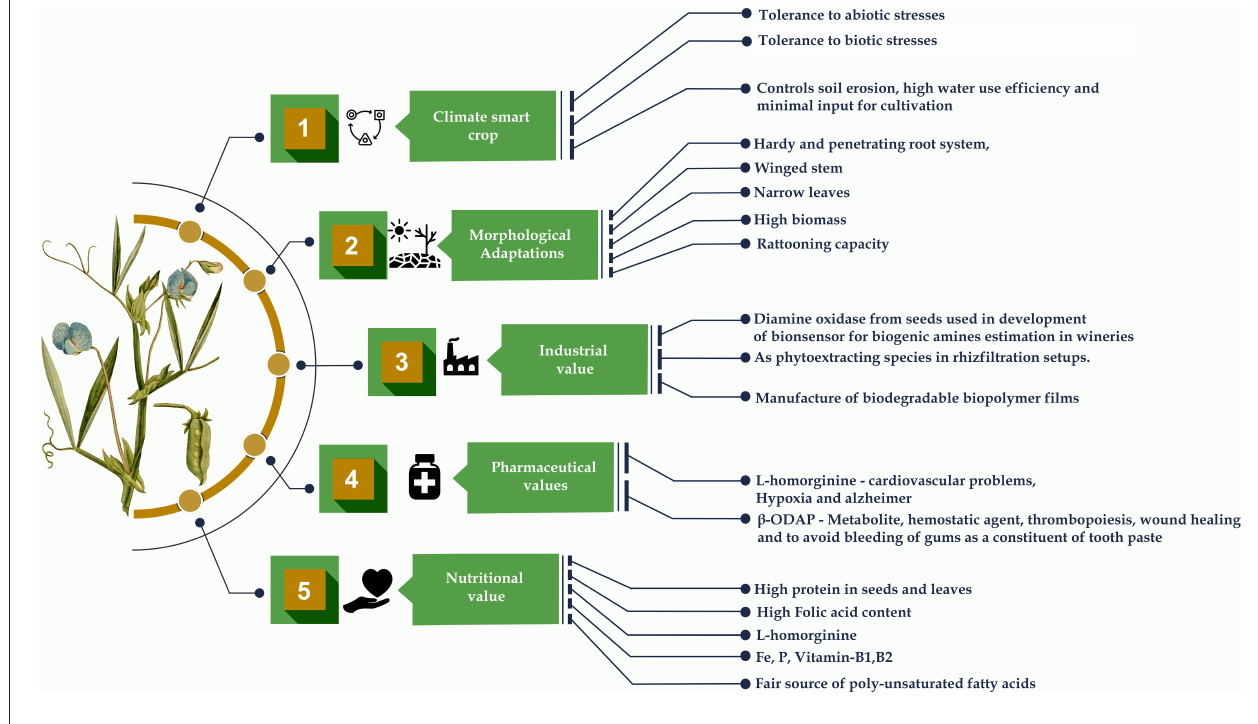
FIGURE 5 | Grasspea as a multifaceted